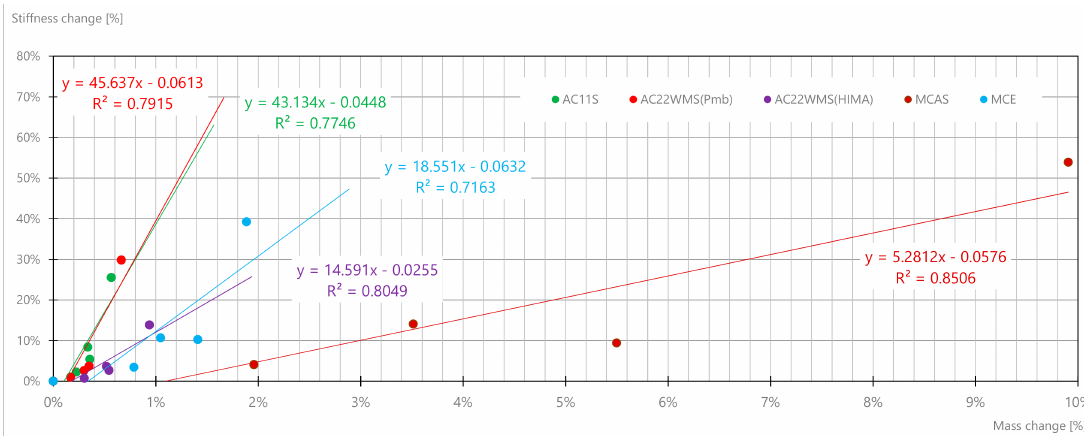
Figure 20. Correlations between modulus change and mass change as a result of the soaking phenomenon for various